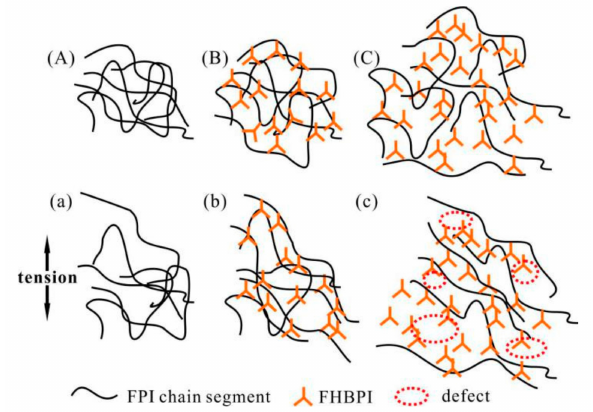
Figure 4. The conceptional pictures of FHBPI distributed in FPI matrix: ( A ) Pure FPI, ( B ) Homogeneous PI / FHBPI physical cross-linking networks at low FHBPI content, ( C ) Aggregated FHBPI molecules block physical cross-linking of FPI molecular chains at high FHBPI content. The ( a – c ) are pictured after the tension,